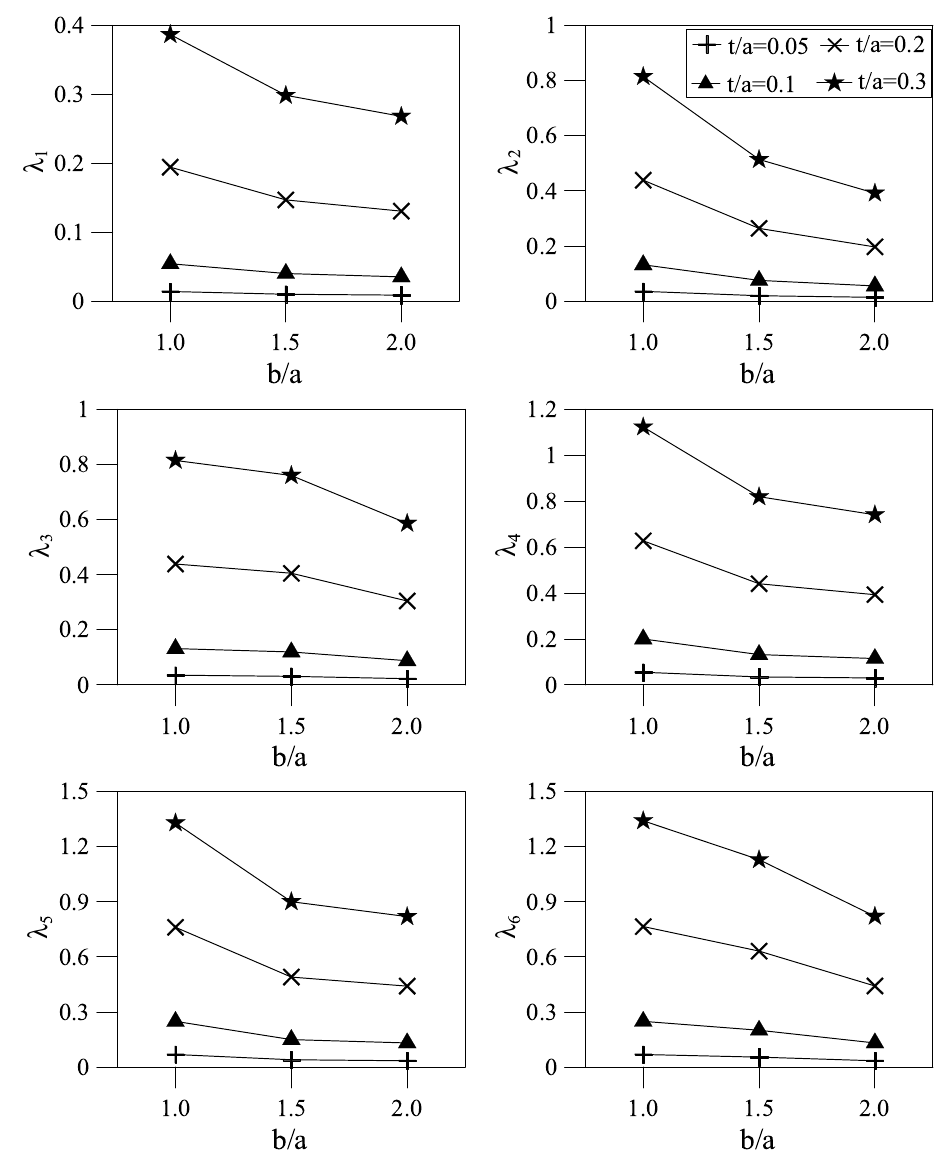
Fig. 4. Effects of aspect ratio and thickness/span ratio on the first six frequency parameters of the thick simply supported plates. increasing t/a ratio for a constant b/a ratio. As also seen from this figure, the decrease in the absolute maximum displacement for a constant b/a ratio increases with increasing b/a ratio. The curves for a constant value of the aspect ratio, b/a are fairly getting closer to each other as the value of t/a increases. This shows that the curves of the absolute maximum displacements will almost coincide with each other when the value of the thickness/span ratio, t/a , increases more. In other words, the increase in the thickness/span ratio will not affect the absolute maximum displacements after a determined value of t/a . In general, the effects of the changes in the thickness/span ratios on the absolute maximum displacement are larger than the changes in the aspect